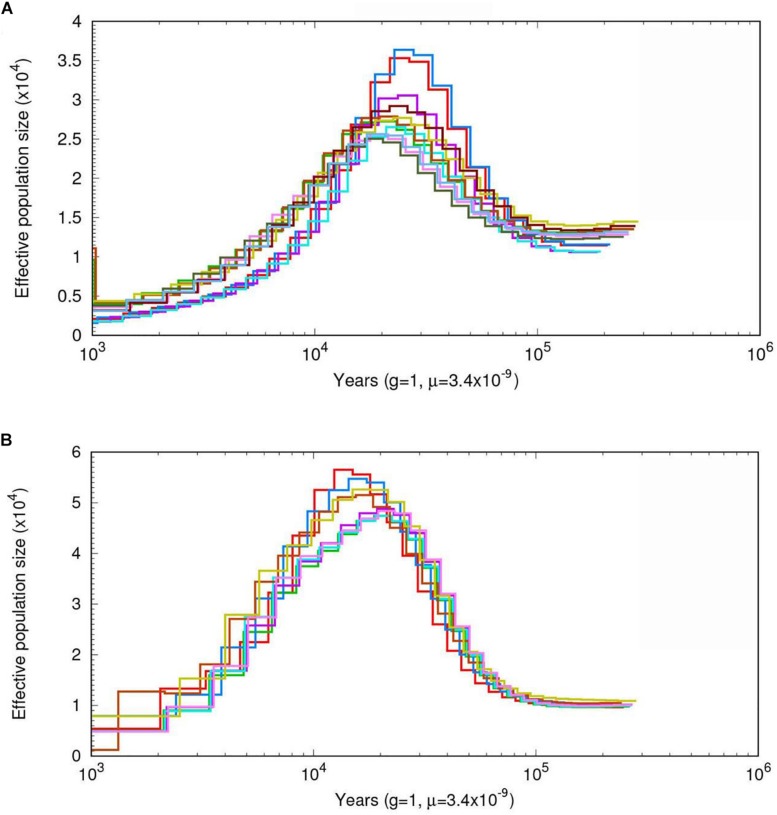
The estimated demographic histories of the two Auricularia populations. Diagrams show effective population sizes over time for (A)
A. cornea, and (B)
A. heimuer. Number at each noder epresents the time of divergence in thousands of years.